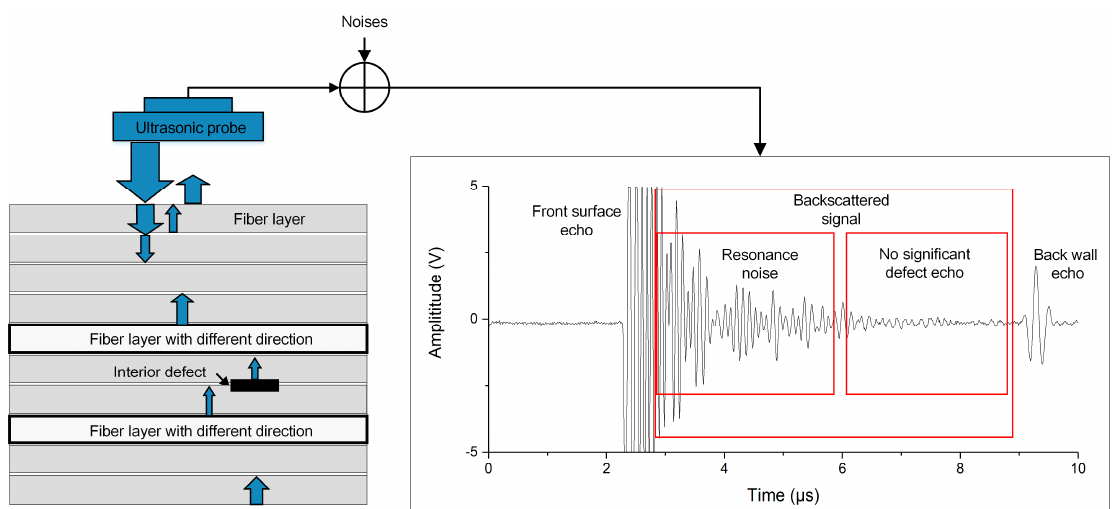
Figure 1. Schematic diagram of the pulse-echo method and an A-scan signal of Carbon Fiber Reinforced Polymer (CFRP) with interior defects and layers with different direction.